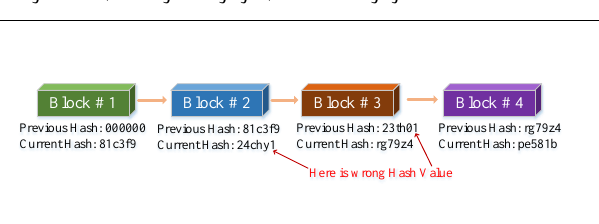
Figure 10. Nodes in the WSNs are linked together in the blockchain under abnormal cases